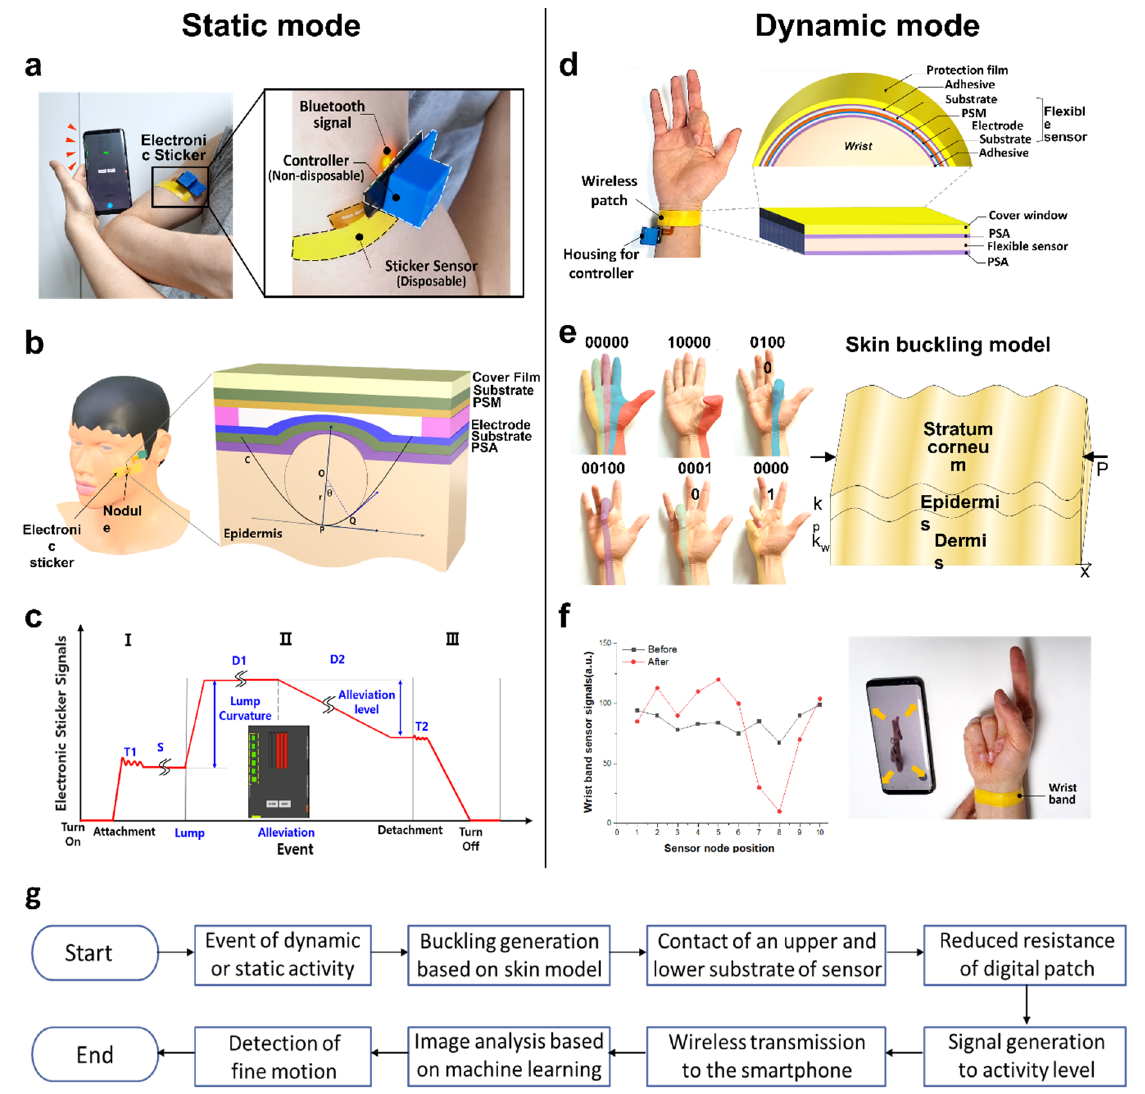
Figure 1. Schematic illustration and photograph of skin-interactive sticker sensors for digital decoding of epidermis deformation. ( a ) The skin curvature signal is transmitted to the smartphone through a digital patch attached to the forearm. This system attached to the forearm consists of a disposable sticker sensor and a non-disposable device housing containing a controller with Bluetooth and battery. ( b ) The digital sticker is deformed by a nodule. Assuming that the nodule is an osculating circle, it causes contact between the upper and lower substrates by the nodule, and the resistance decreases. ( c ) The signal change stage is according to the event in the digital patch. The sensor signal reception is divided into three stages: skin attachment and idle mode ( I ), curvature change stage ( II ), and detachment step ( III ). T , S , and C represent areas for transition, stabilization, and curvature change processes. At stage ( II ), the nodule curvature and alleviation degree can be measured. ( d ) The structure of the skin-interactive tactile sensor is attached to the wrist. ( e ) Deformation color map and binary number of wrist epidermis according to finger movement. ( f ) Sensor signal intensity before and after finger folding ( left ). Zoom-in and zoom-out user interface through finger gesture ( right ). ( g ) Sensing methodology diagram of the digital patch.